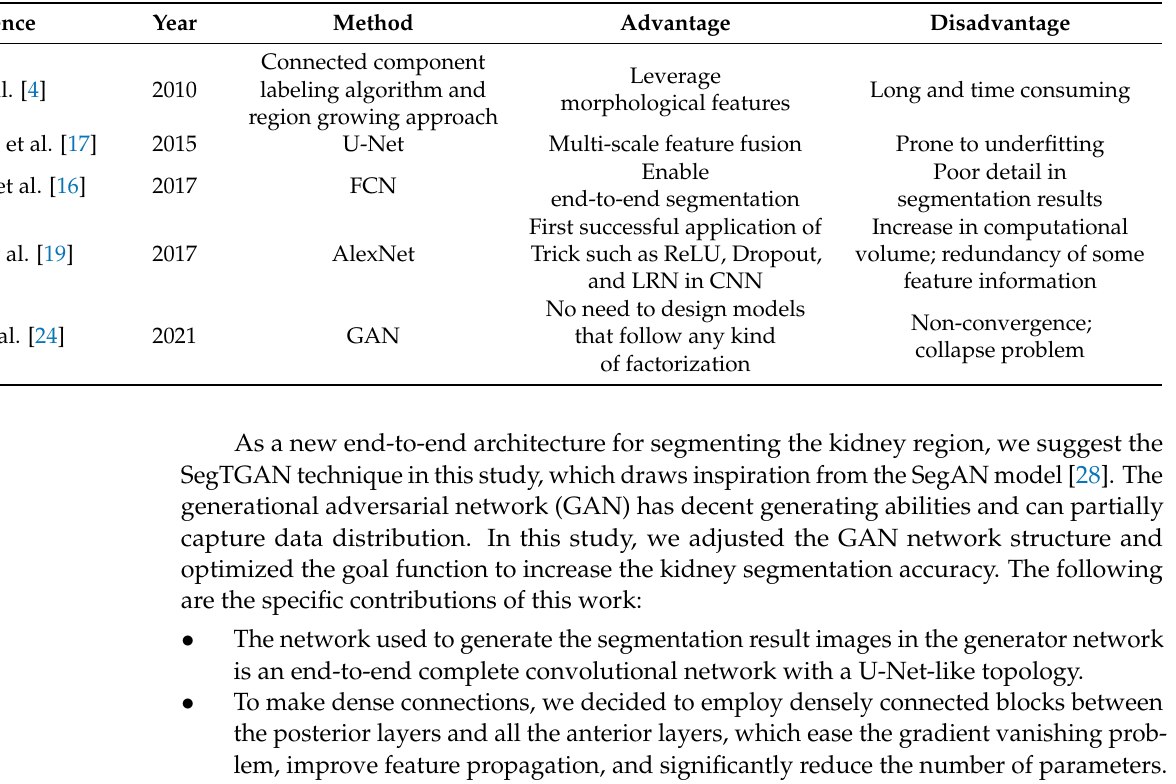
Table 1. Pros and cons of several representative